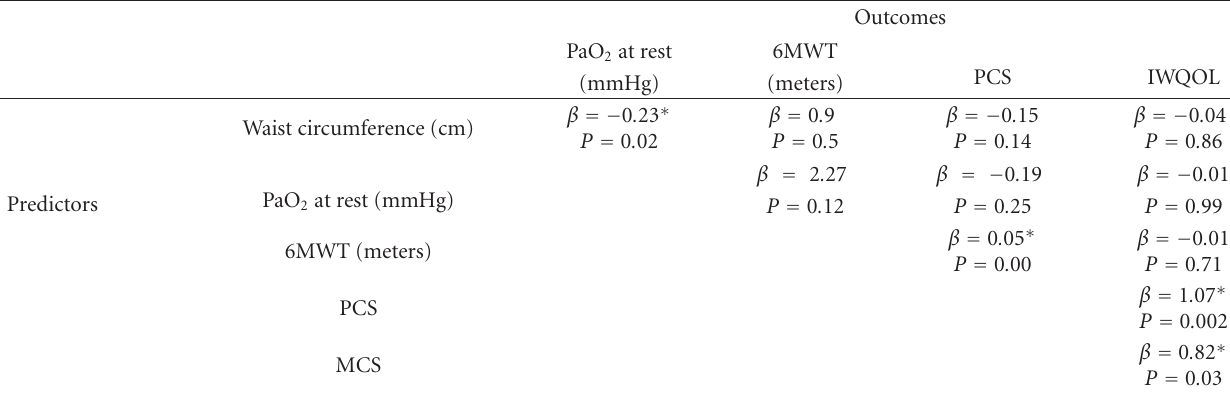
Table 3: Multiple linear regression